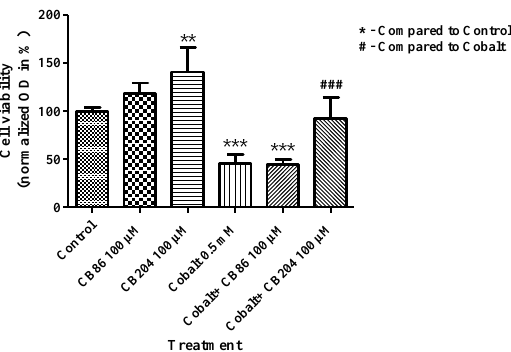
Figure 7. The protective e ff ect of TSPO ligands in preventing the decrease in cellular viability. XTT assay was performed to measure the levels of cellular viability following CoCl 2 exposure with or without TSPO ligands pretreatment. Results are expressed as mean ± SEM ( n = 5 replicates in each group). ** p < 0.01, ### and *** p < 0.001.